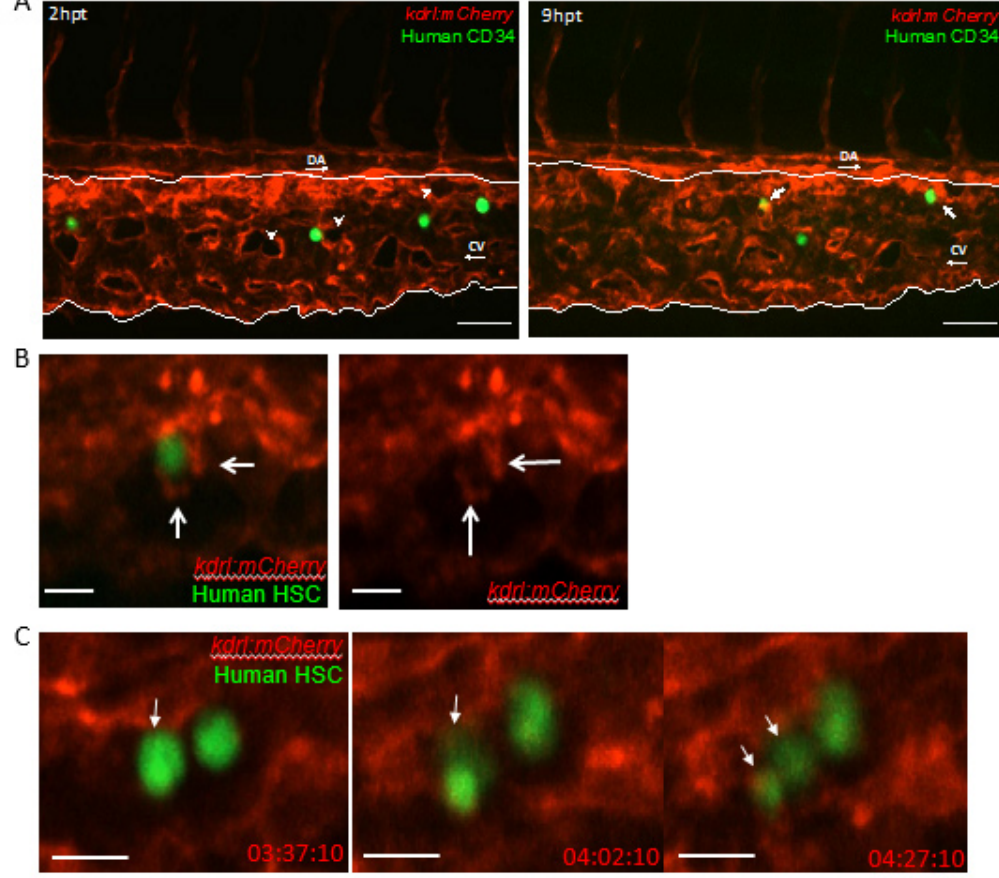
Figure 5. Human CD34 cells interact with zebrafish endothelial cells. Spinning disk confocal stills of timelapses zebrafish Caudal Haematopoietic Tissue (white lines) from the endothelial cell (red) reporter line Tg(kdrl:mCherry) zebrafish larvae transplanted with human CD34 cells (green). ( A ) At 2hpt, human CD34 cells are still in the vessels and empty perivascular pockets (white arrowheads) do not contain human CD34 cells. At 9hpt, human CD34 cells co-localised with endothelial cells and human CD34 cells appears inside the perivascular pockets (white arrows). DA: Dorsal aorta, CV: Caudal vein. Scale bar= 50μm. ( B ) High magnification of a human CD34 cell being ‘cuddled’ by surrounding endothelial cells, note the endothelial cell protrusion acting like arms (white arrows). Single Z plane from a Z-stack. Scale bar= 50μm. N=1 ( C ) Division of a human CD34 cells (white arrow) within a perivascular pocket of a 56hpf embryos, with hours post transplantation (hpt) displayed. Note the equal distribution of fluorescence between the two daughter cells in the last frame. N=1. Single Z plane from a Z-stack. Scale